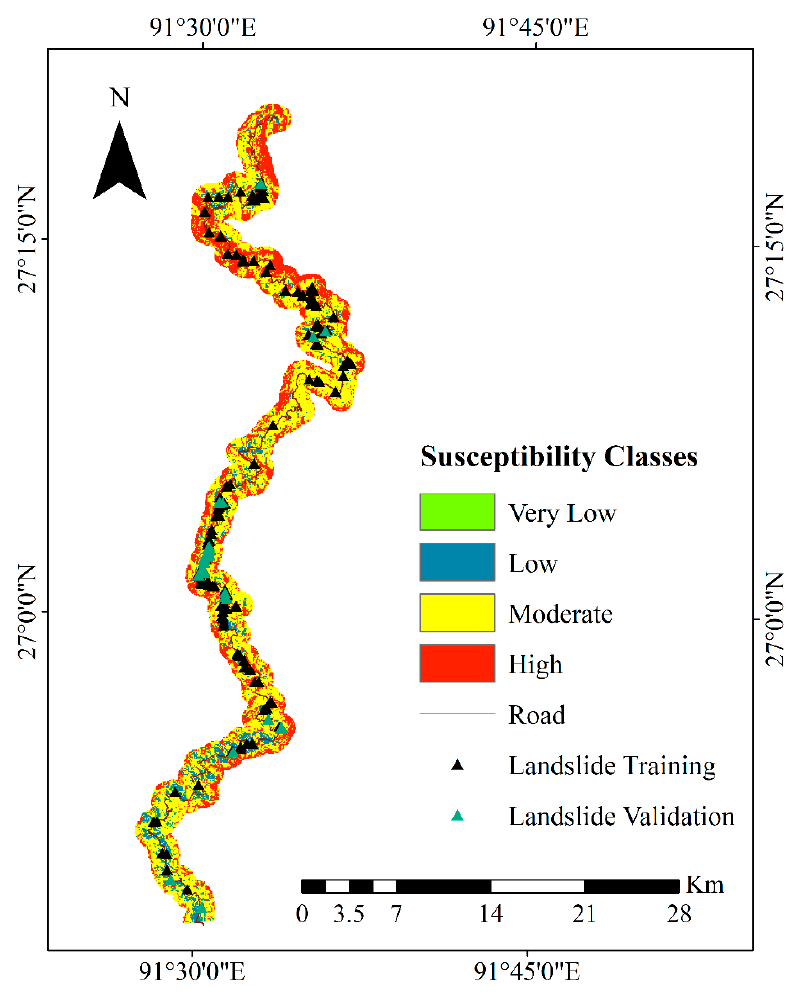
Figure 10. Landslide Susceptibility Map of the Study Region. Table 5. Landslide Susceptibility Results for the Samdrup Jongkhar–Trashigang Highway